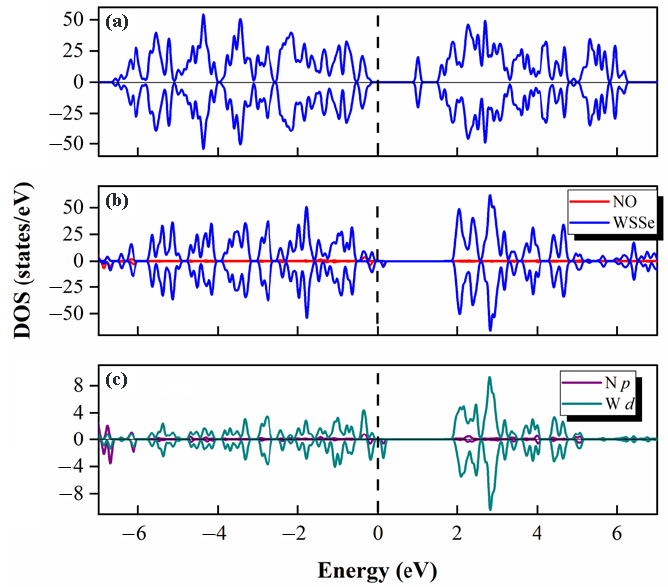
Figure 6. ( a ) Total DOS of the defective WSSe without NO adsorption. ( b ) The adsorption system’s partial DOS. Dark blue indicates the WSSe component, whereas red indicates the NO portion (the enlarged view is shown in Figure S1). ( c ) The N p orbitals from the adsorbed NO gas molecule (marked in dark purple) and the W d (marked in dark green) orbitals of these three W atoms that are attaching to the N atom from NO. The Fermi level is indicated by the vertical dashed